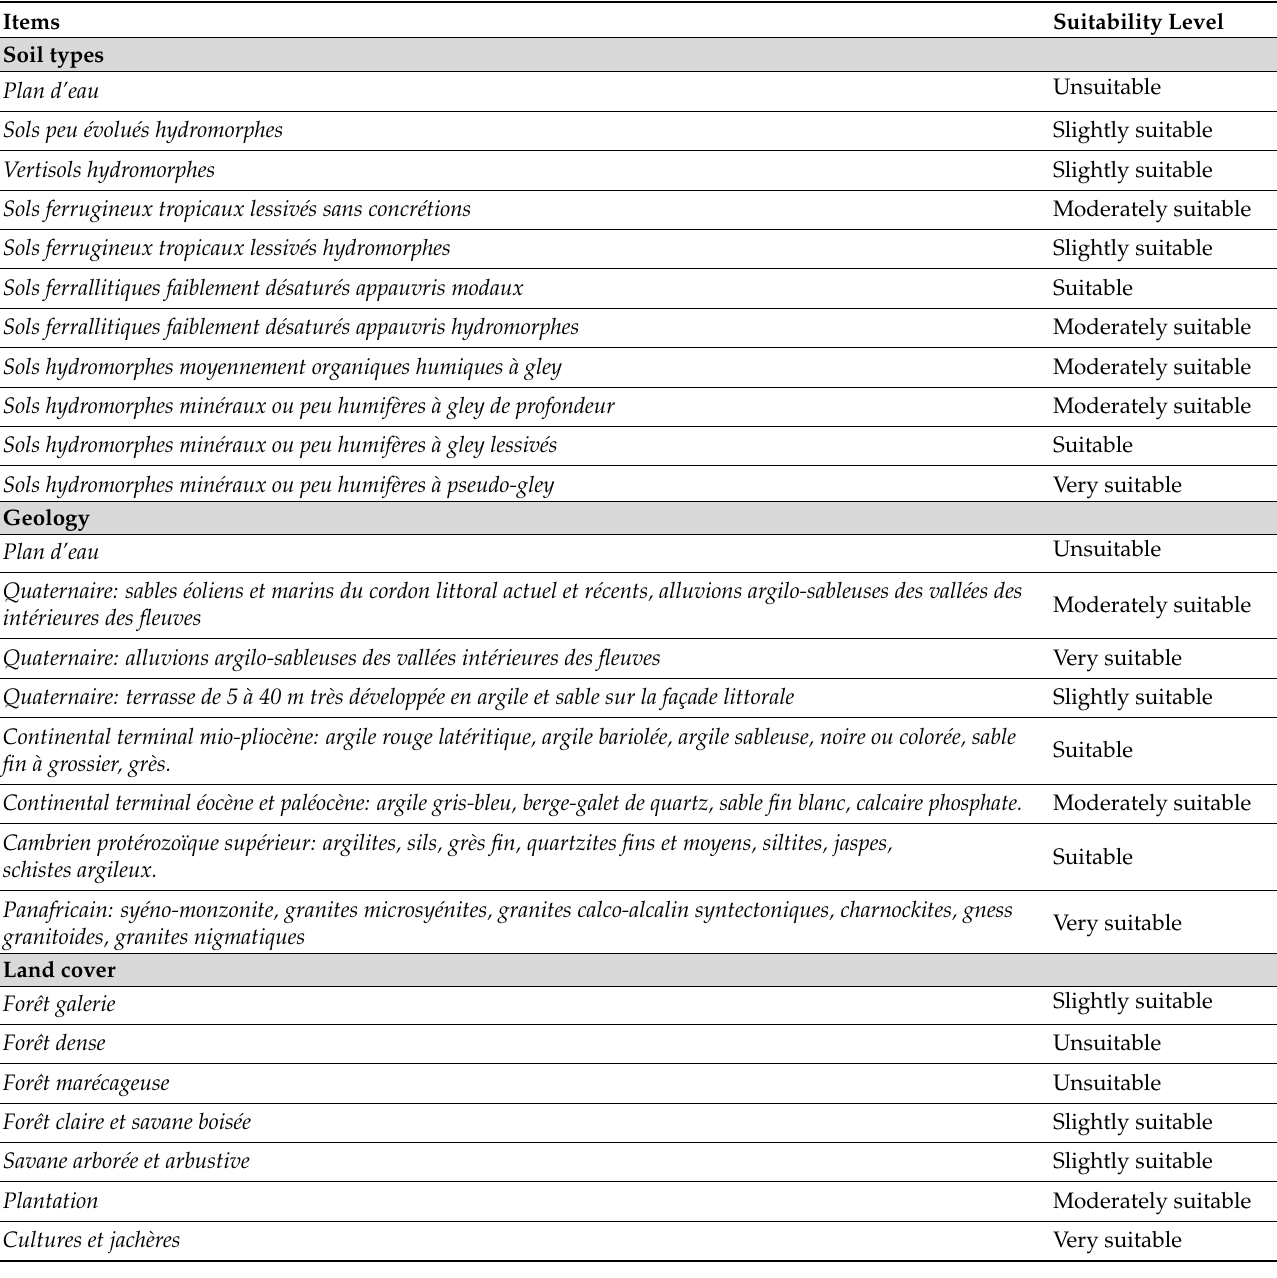
Table A1. Evaluation of soil, geological and land-use suitability (original French